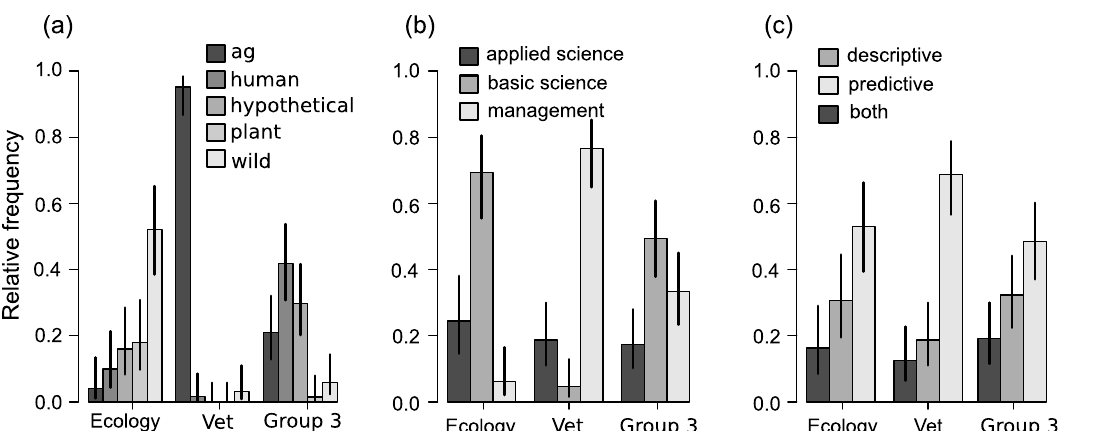
Fig 3. Model objectives from the three journal communities. (A) Study system: agricultural (domestic animals), human, hypothetical, plant, or wildlife. (B) Applied, basic science, or management objectives by community. “ Applied science ” was used to describe scenarios in which basic science questions were addressed using systems of management interest. (C) Predictive or descriptive modeling intent. Error bars depict 95% binomial confidence bounds. Data to generate this figure are contained in S2 Data.